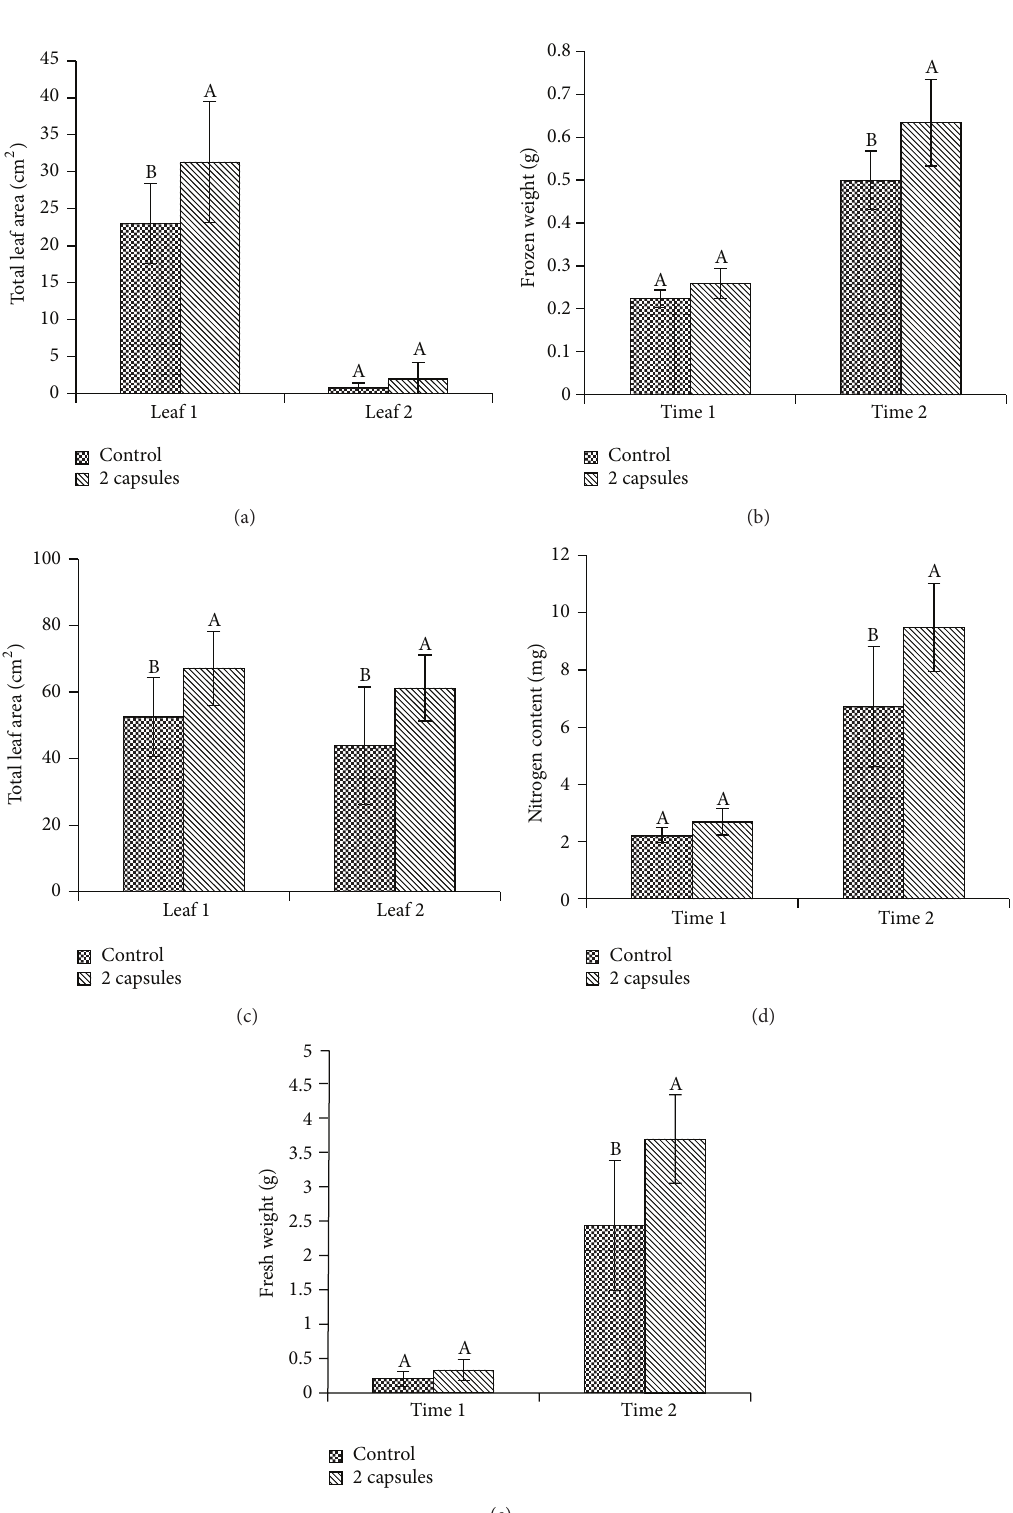
Figure 1: Evaluation of the effect of cucumber (“Vlaspik”) seed gelatin treatment on plant growth and nitrogen content. Data were analyzed by ANOVA ( 𝛼 = 0.05 ), and Tukey’s HSD test was then used to compare mean separation. Letters not associated with the same letter were significantly different. Bars represent standard deviation. Legend shows control and gelatin capsule treatment (2 capsules). (a) Total leaf areas at one week after emergence (T1) between control and gelatin capsule treatment (2 capsules). First leaf (leaf 1) and second leaf (leaf 2) were harvested separately. (b) Total leaf areas at two weeks after emergence (T2) between control and gelatin capsule treatment (2 capsules). (c) Fresh weight at one week after emergence (time 1) and two weeks after emergence (time 2). (d) Frozen weight at one week after emergence (time 1) and two weeks after emergence (time 2). (e) Nitrogen contents at one week after emergence (time 1) and two weeks after emergence (time